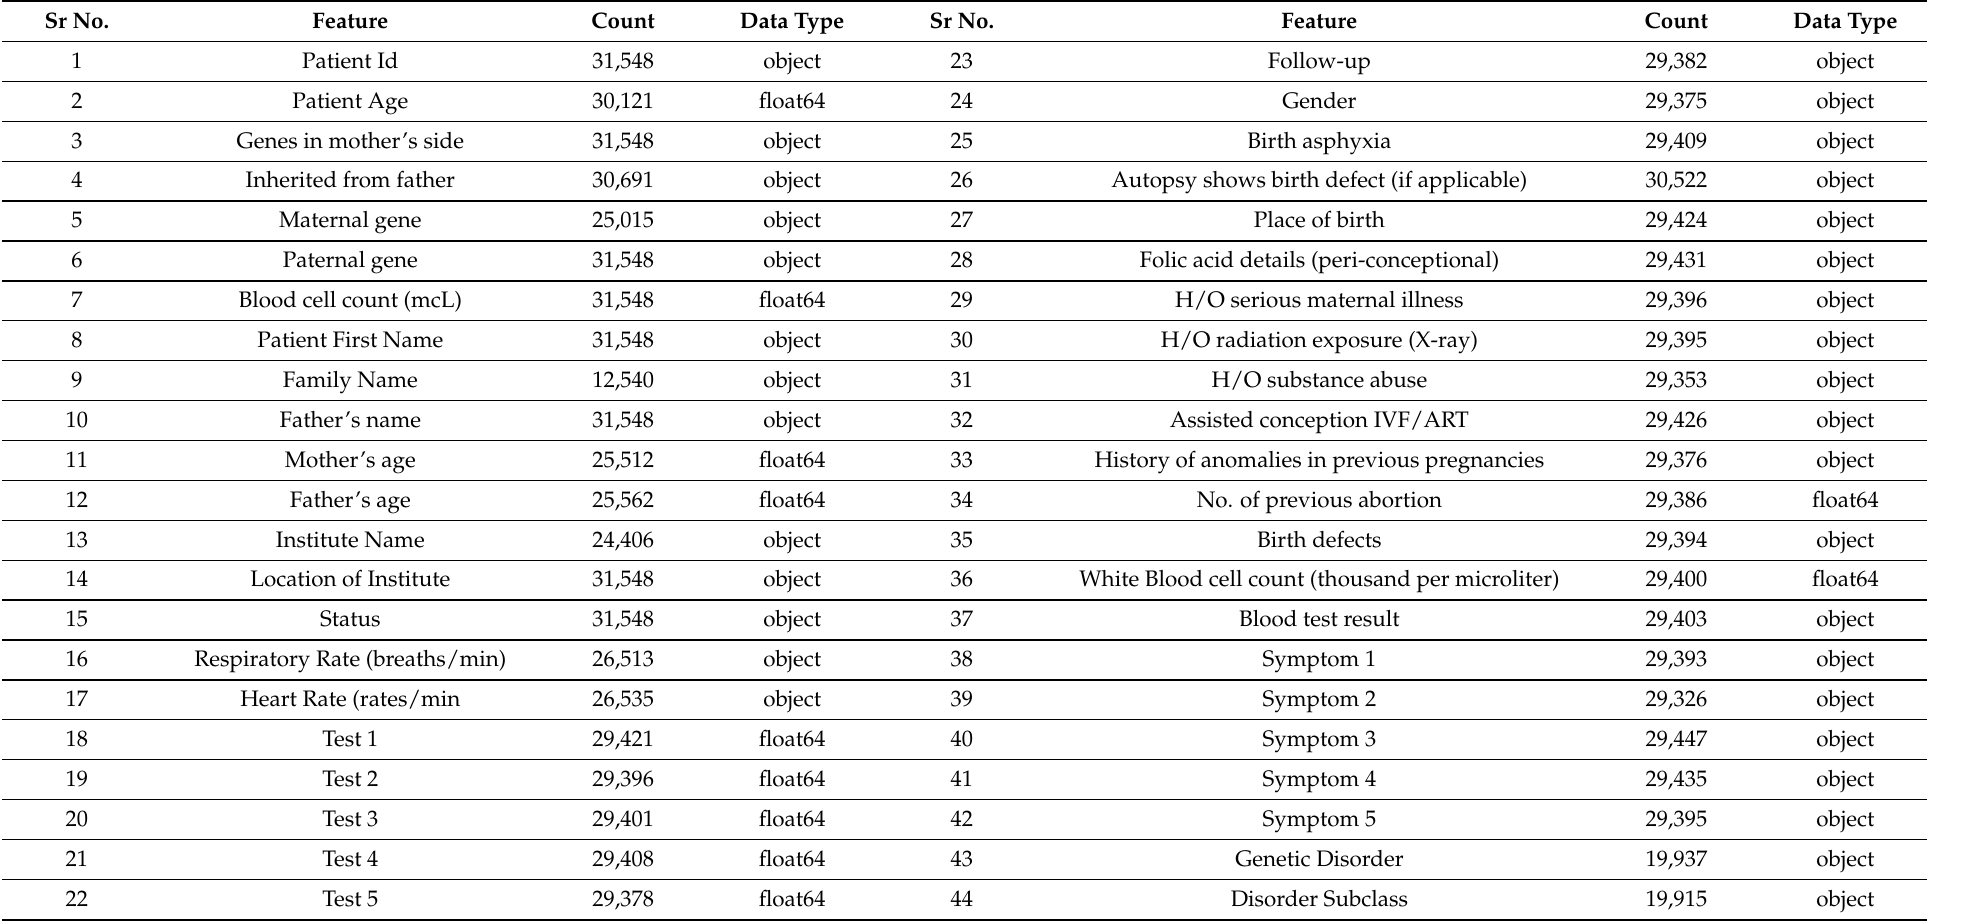
Table 2. The genomes dataset features descriptive